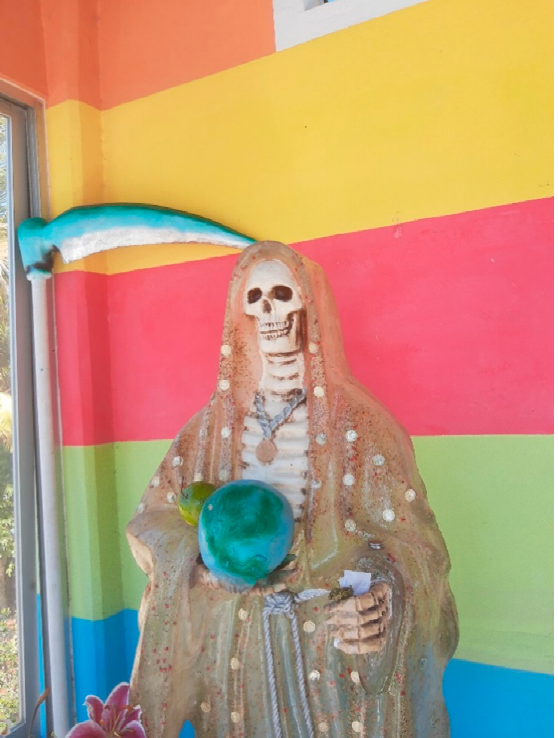
Figure 1. Statue of Santa Muerte photographed in Oaxaca by the anthropologist. Note the prayer written on a piece of paper and placed in her outstretched hand. There is also an offering of marijuana on it. A gift of fruit has been placed by a devotee above the globe she carries. The folk saint is turned to for miracles of all kinds, from health, wealth, love to good fortune. And like most folk saints, Santa Muerte is amoral, therefore she may also be supplicated not only for good deeds but also bad, such as to bring death and bad luck to enemies. For this reason, Santa Muerte has often been mislabeled by the press, media and US law enforcement authorities as a narco-saint, that is to say a saint venerated solely by narco-traffickers (Kingsbury and Chesnut 2020a).In previous articles and a